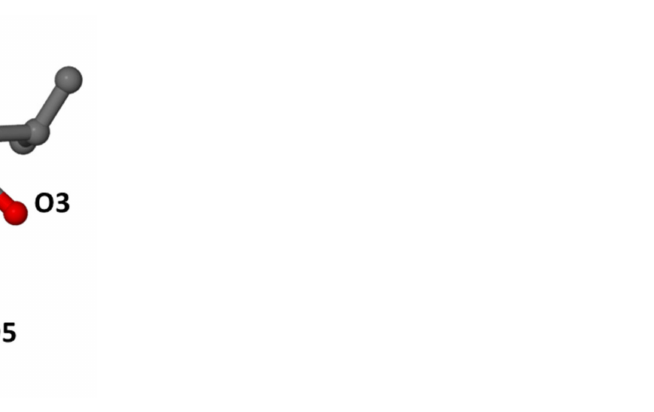
Figure 2. X-ray crystallographic structure of compound 2 . Selected hydrogen atoms are shown for clarity. Table 2. Single-crystal X-ray parameters of 7 α -acetoxy-6 β -hydroxyroyleanone ( 2 ).